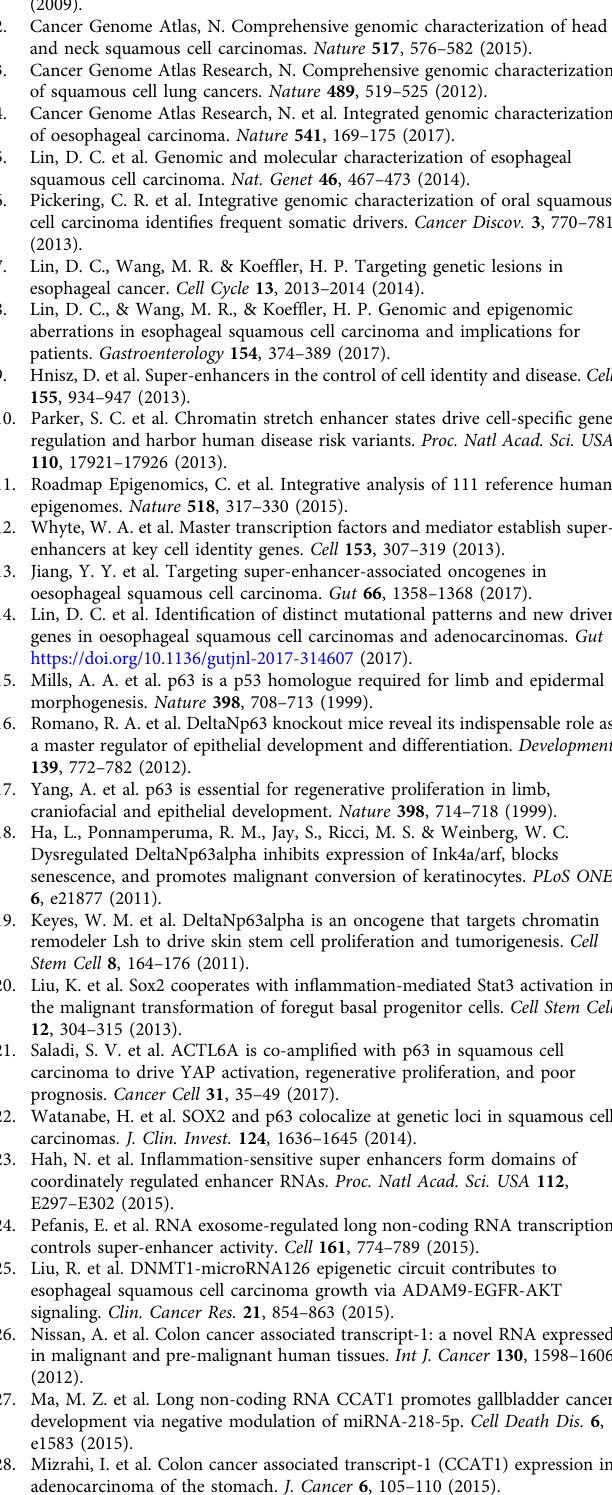
Human phospho-kinase array . Human phospho-kinase array was performed according to the manual instructions (R & D Systems). Brie fl y, cell lysate were diluted into the desired quantity (1 µg/µl, 200 – 300 µg per sample for one experi- ment), incubated with membranes (A and B parts) overnight at 4 °C on a rocking platform. The membranes were then incubated with detection antibody cocktail A or B for 2h following by Streptavidin-HRP for another 30 min at room tem- perature on a rocking platform shaker. Signal detection applied the Chemi Reagent Mix and exposed to fi lm. RIP experiments . To study interactions of TP63 or SOX2 protein with CCAT1, RIP was performed using the published protocols 55 . Brie fl y, cell lysates were fi rstly incubated with Dynabeads protein A/G to remove non-speci fi c binding. The precleared lysate was incubated with indicated antibody or the same type of